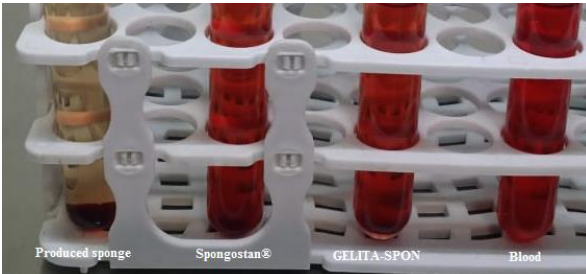
Figure 9. The results for blood clotting index (BCI).